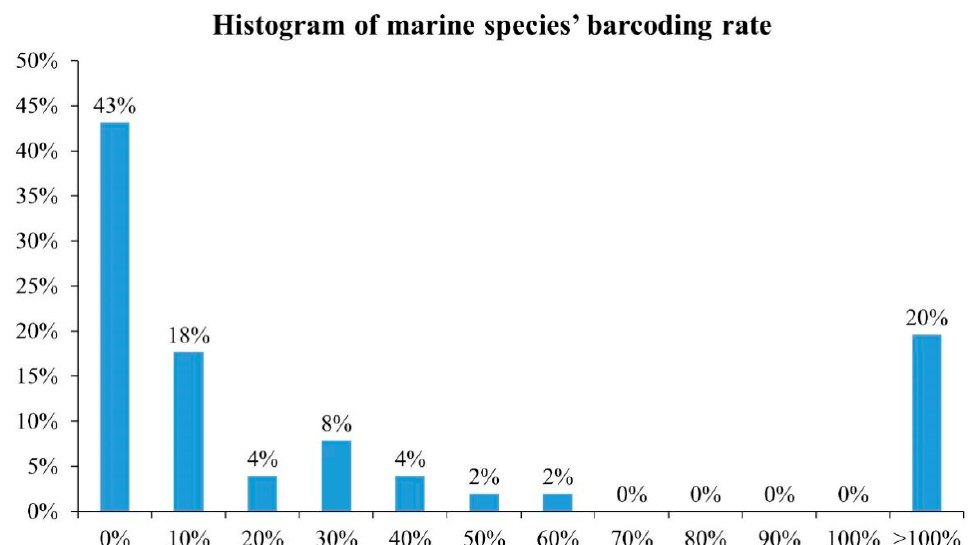
Figure 1. Histogram of marine species’ barcoding rates. The marine species’ barcoding rates were calculated using the data in Table 1. The percentages of the abscissa indicate the percentage of the number of species, and the percentage of the ordinate indicates the frequency of the barcoding rate. As the histogram shows, most (65%) marine species’ barcoding rate is less than 30%. Almost half (43%) of marine species’ barcoding rates fall in the range of 0–10%. The DNA barcoding rates are still relatively low. Meanwhile, 20% of marine species’ barcoding rates are larger than 100% because the data from BOLD are not focus on marine species.